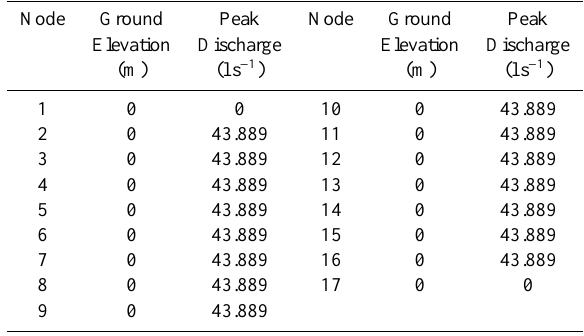
Table 1. Characteristics of the pipes. Table 2. Characteristics of the